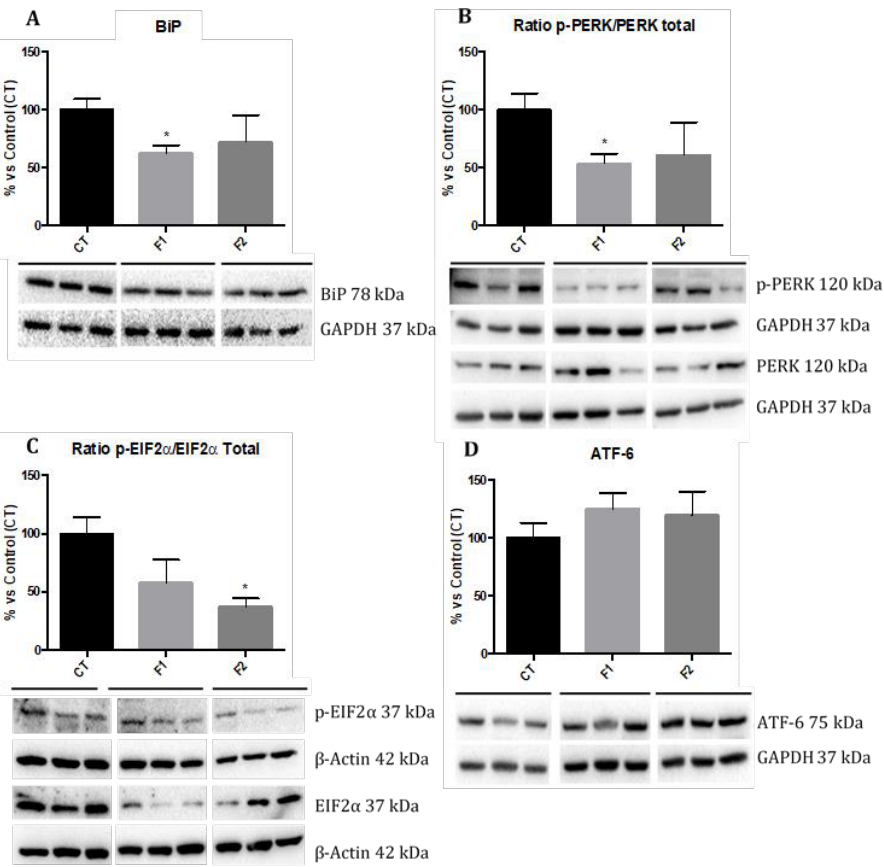
Figure 6. Endoplasmic Reticulum (ER) stress markers sensors in the hippocampus of females and males at 6 months of age for all mice groups. Representative Western blot for BiP), ratio p-PERK/PERK Total, ratio p-EIF2 α /EIF2 α , ATF-6 and their respective quantification ( A – D ). Values in bar graphs are adjusted to 100% for protein levels of the CT group). Values are the mean ± SEM; n = 18 (CT n = 6, F1 n = 6, F2 n = 6 for each group, females n = 3, males n = 3). Statistics: * p < 0.05.